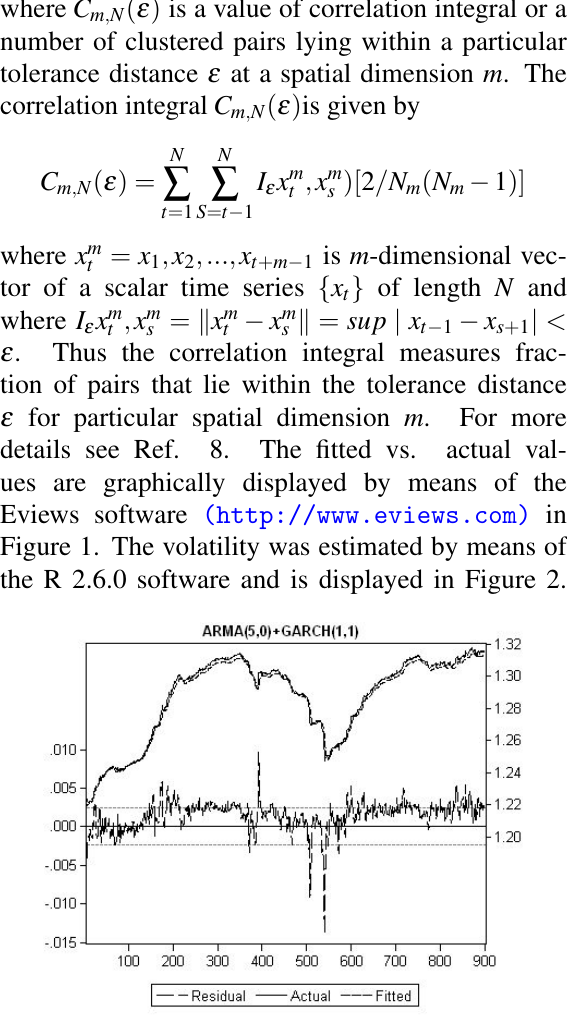
Fig. 1. Actual and fitted values of the VUB fund: ARMA(5,0)+GARCH(1,1) - model (6). Residuals are at the bottom. Actual time series represents the solid line, the fitted vales represents the dotted